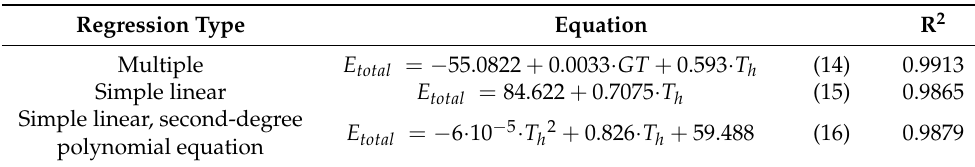
Table 15. Regression curves in the total emissions calculation.